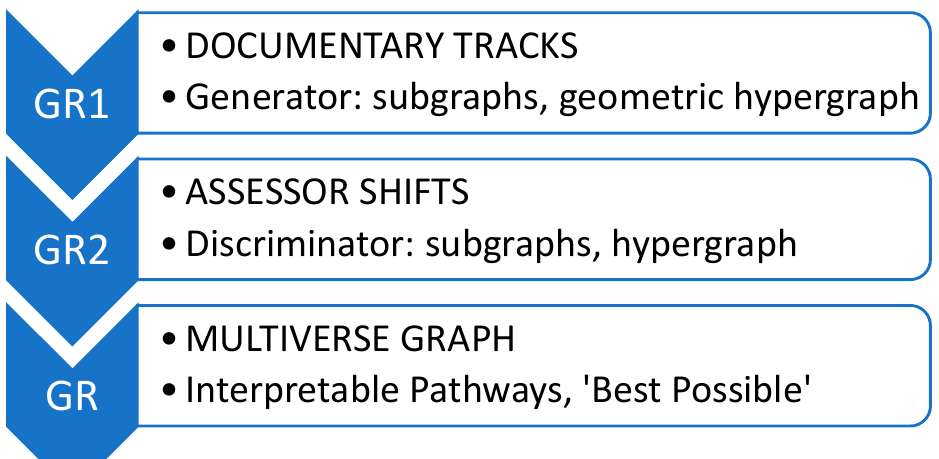
Scheme 1. The schematic structure of GRAPHYP. Identifying assessor shifts from logs of documentary